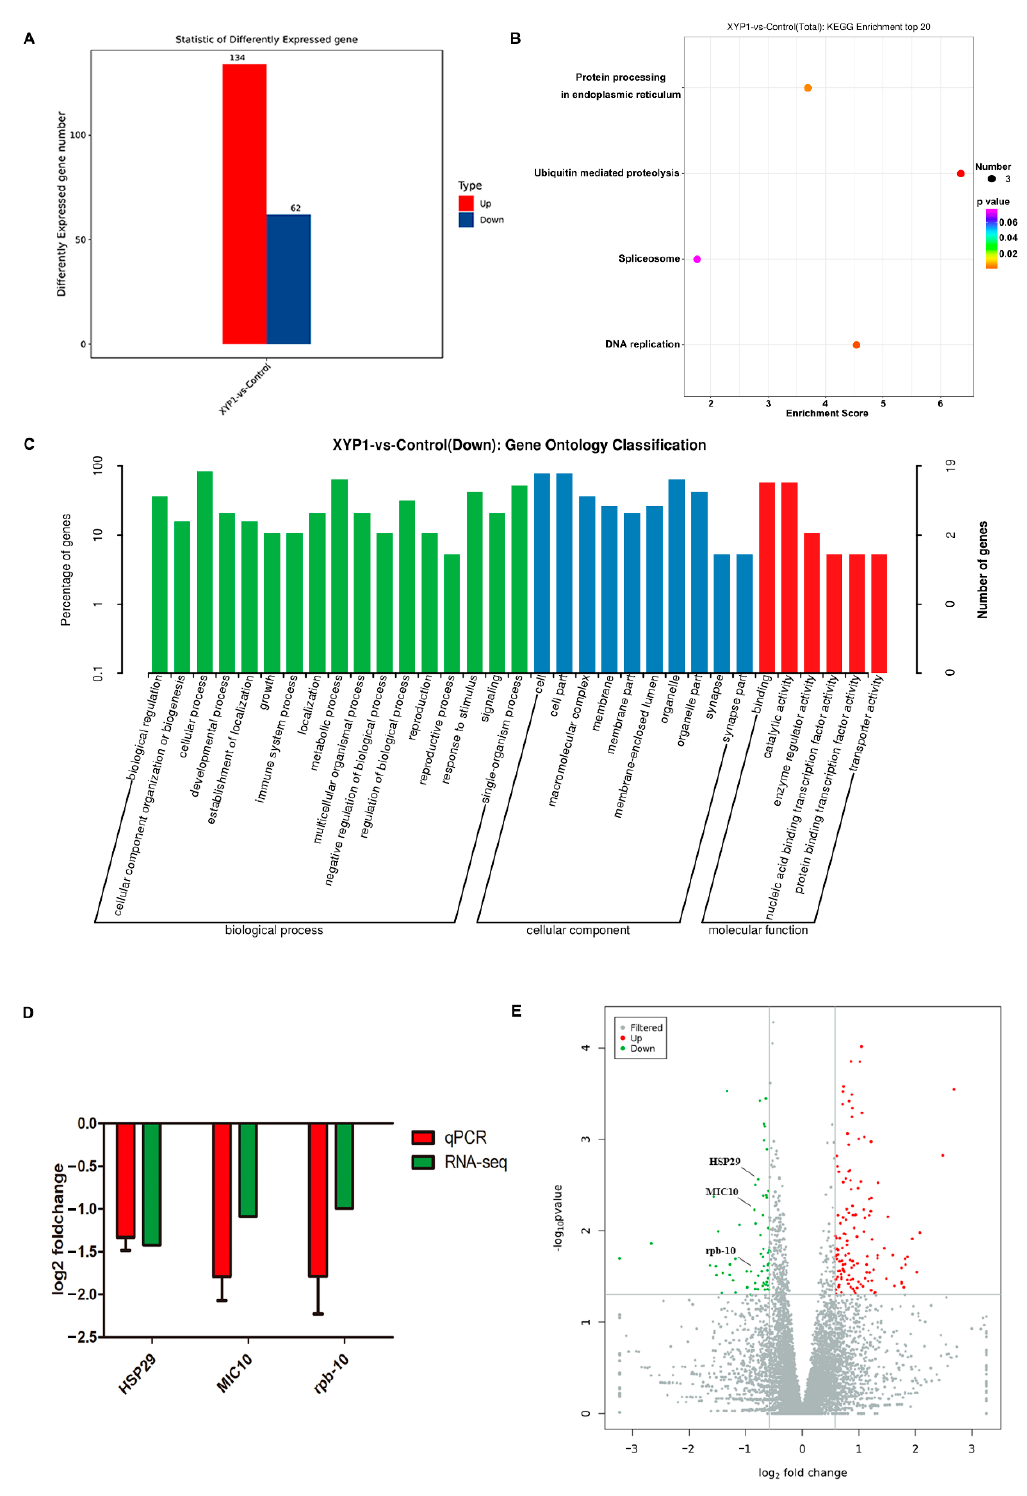
Figure 7. Gene expression profiles after XYP1 treatment and verification of the RNA-seq data by qRT-PCR. ( A ) The numbers of T. gondii DEGs after 8 h XYP1 treatment. ( B ) KEGG pathway enrichment. ( C ) GO classification. ( D ) Verification of the RNA-seq data by using qRT-PCR. ( E ) Volcano plot of DEGs. Significantly upregulated and downregulated genes are marked with red and blue spots, respectively.